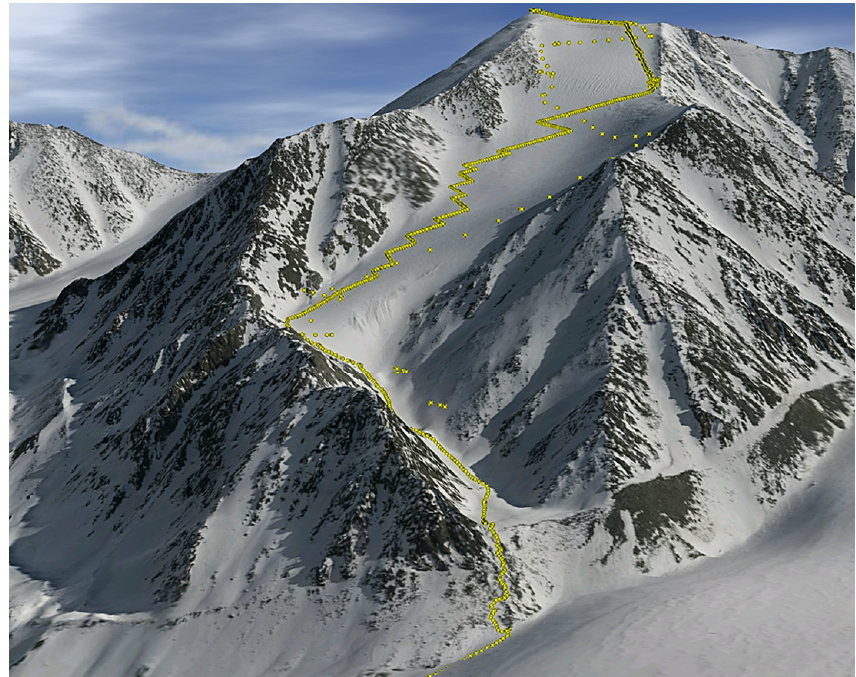
Figure 2. Mt. Isto, currently the tallest peak in the US Arctic, shown as a 3-D visualization of our fodar data. Yellow dots indicate the position of some of the ground control points collected (yellow) used for validation, spanning ∼ 1000m. Closely spaced points are on the climb up; widely spaced points are on the ski